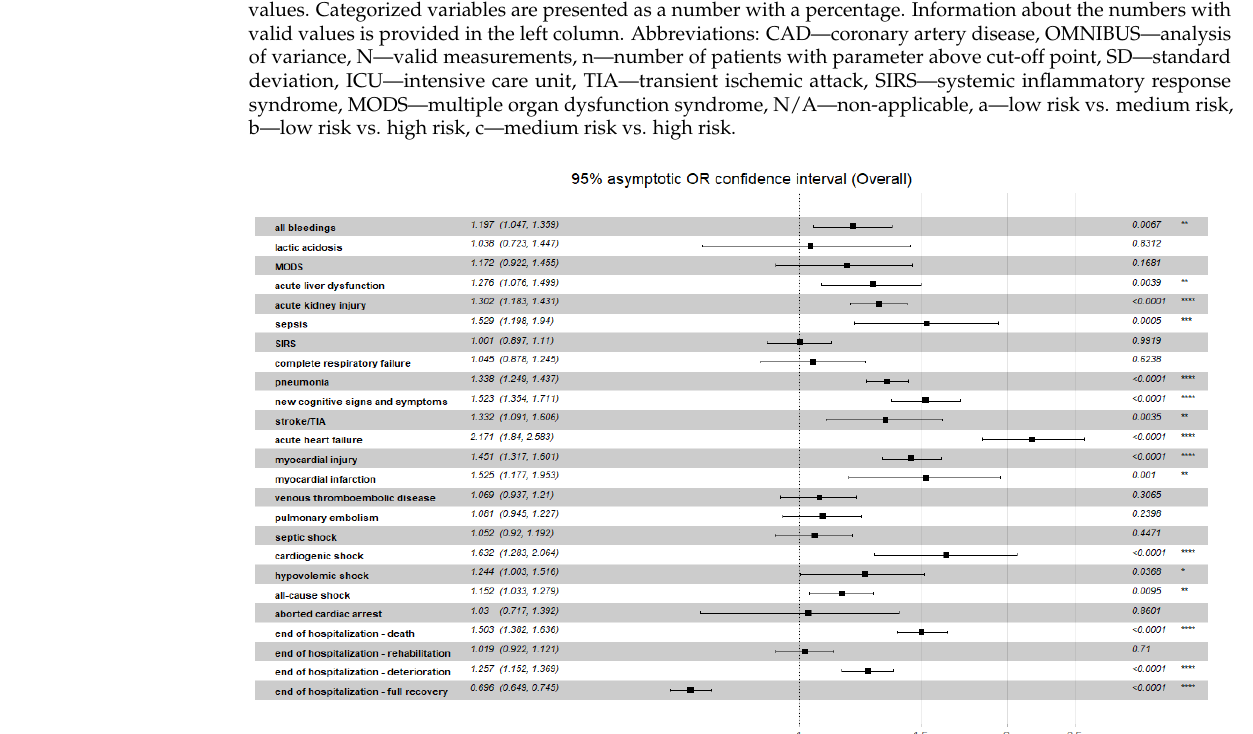
Figure 5. Overall odds ratio for the discriminatory performance of the C 2 HEST score for clinical